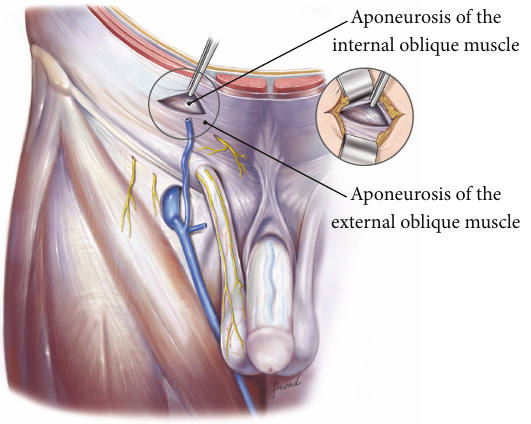
Figure 1: The incision is marked by the index and third fingers as shown.